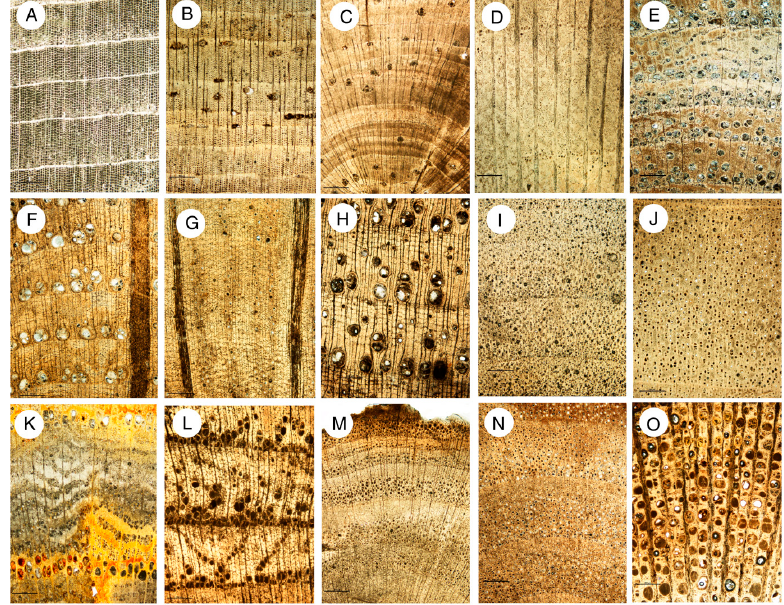
Figure 13. Fossil wood types from the Bruneau Woodpile (University of Washington Burke Museum Figure